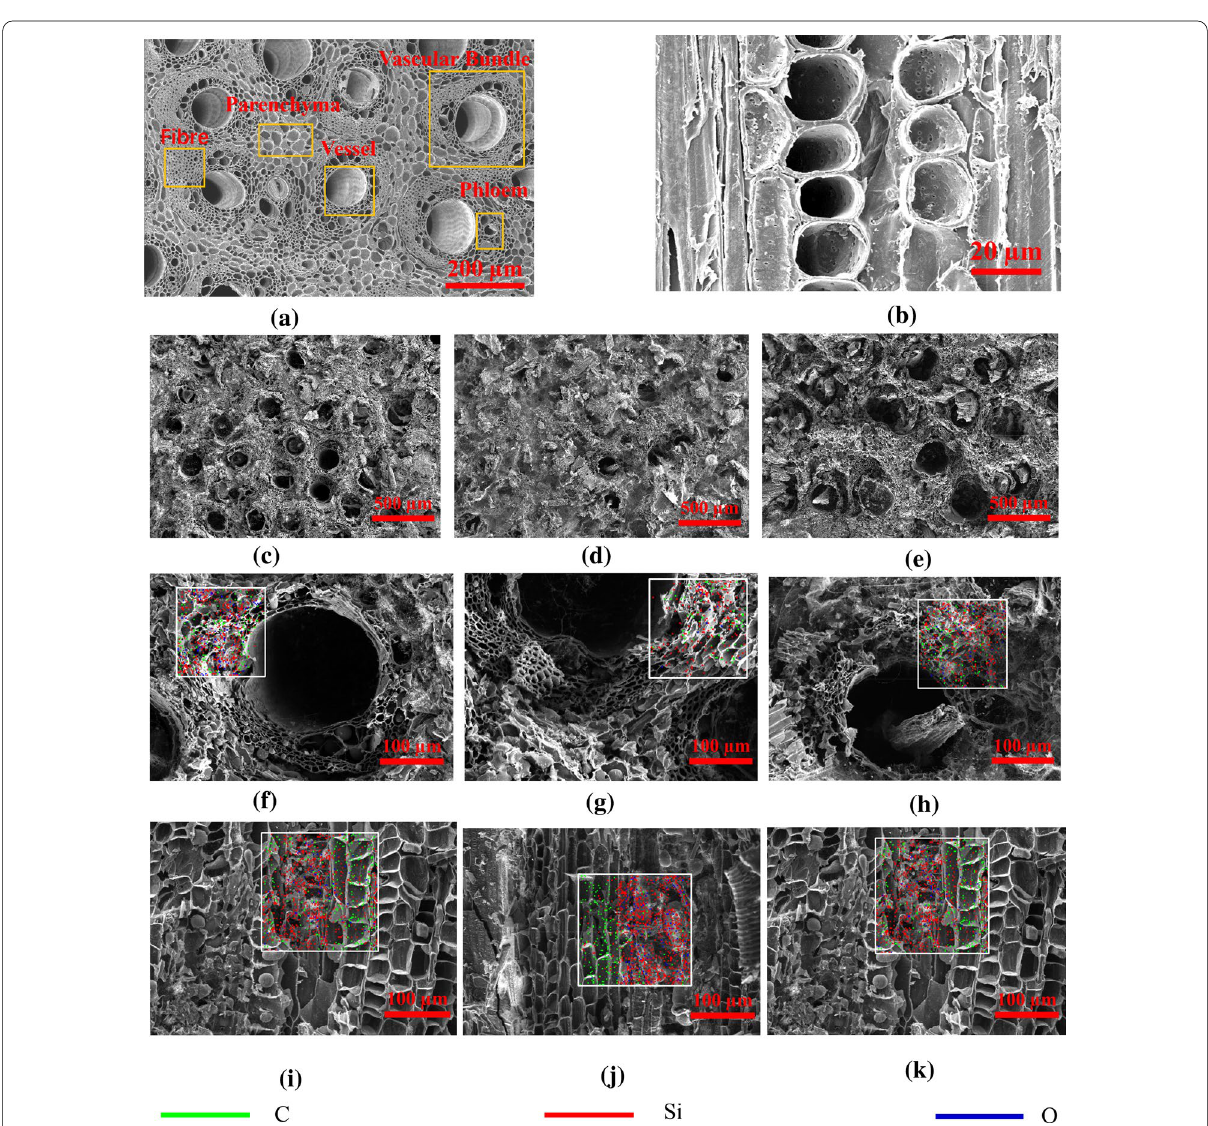
Fig. 4 The FESEM of pristine rattan and the FESEM and the corresponding EDX image of the R–SiC prepared at different temperatures. (Pristine rattan: a , b ; R–SiC T1300t120 : c , f and i ; R–SiC T1400t120 : d , g and j ; R–SiC T1500t120 : e , h and k